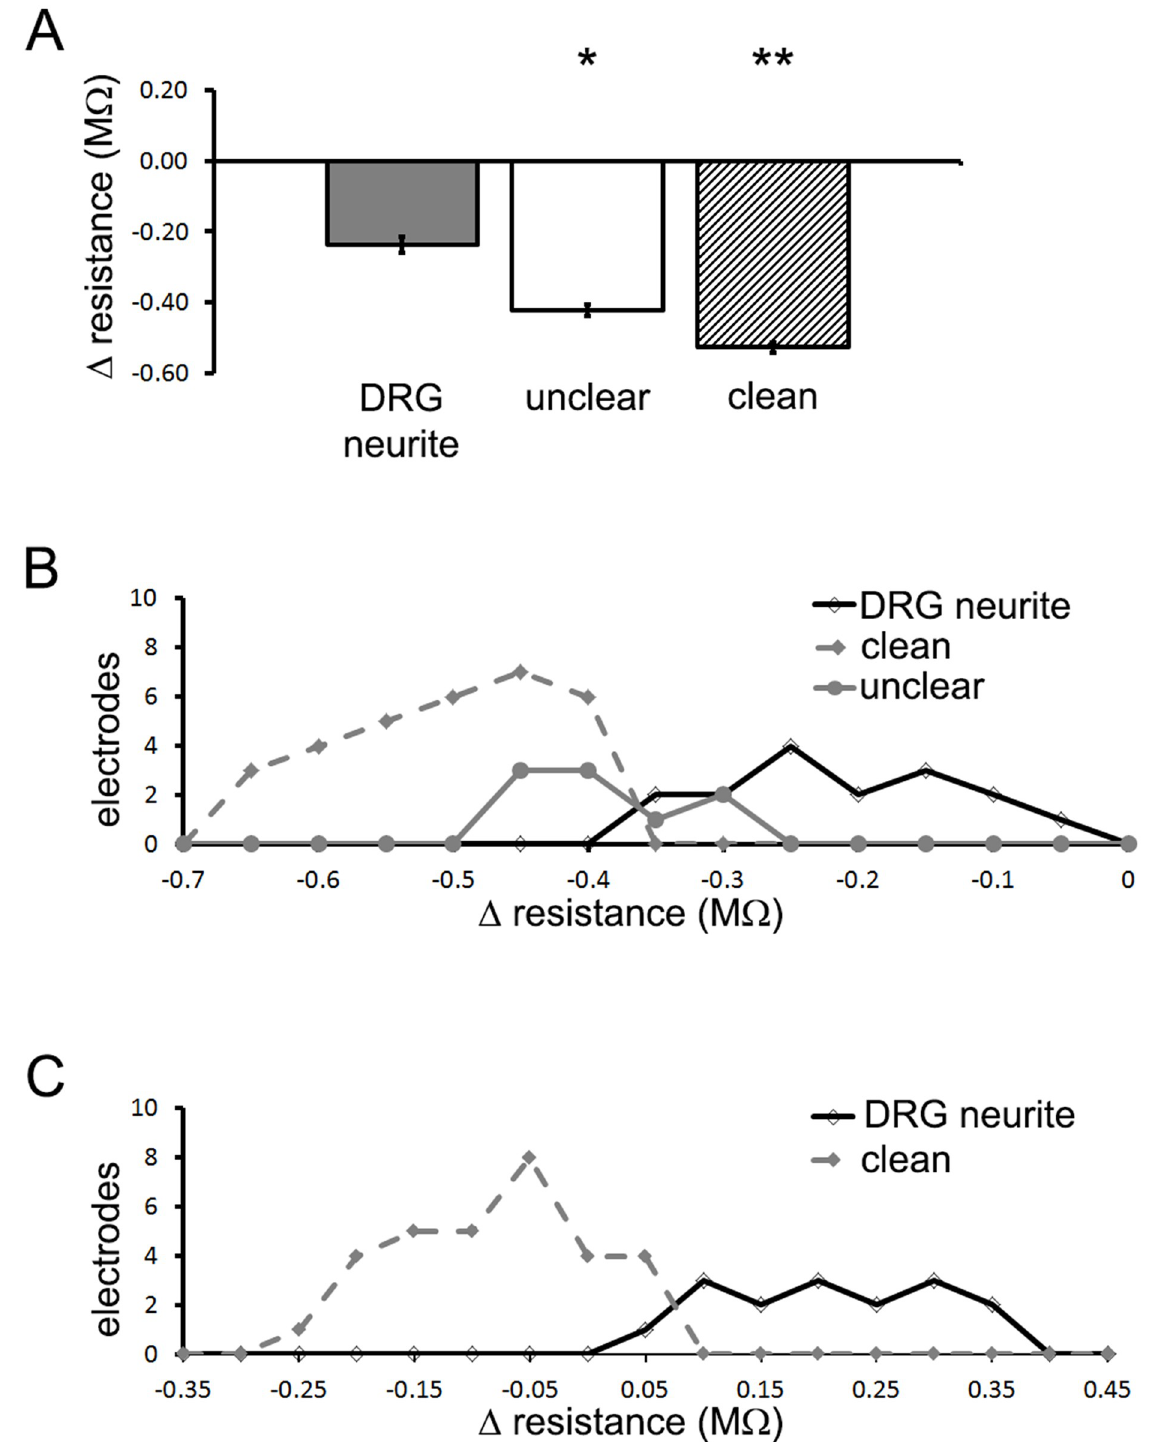
Fig 2. Electrode resistance values can reflect DRG neurite contact with electrode. In a single experiment resistancevalues from electrodeswere averagedby classification(DRG neurite, UNCLEAR, or CLEAN). The soma in this experiment was not placedin contact with any electrodes. (A) The change in resistancefor electrodes in contact with a DRG neurite (-0.24 ± 0.02 M Ω ; n = 16; p < 0.001; F = 69.685) were significantly less than for electrodesclassified as UNCLEAR (-0.42 ± 0.02 M Ω ; n = 19; p < 0.001) or CLEAN (-0.53 ± 0.01 M Ω ; n = 31 electrodes). (B) The distributionof the change in electrode resistances for CLEAN electrodes, UNCLEAR electrodes and electrodes contacted by a DRG neurite were plotted in a frequency curve (0.5 M Ω bins). (C) The averagechange in resistanceof UNCLEARelectrodeswas background subtracted across all electrodes in a single